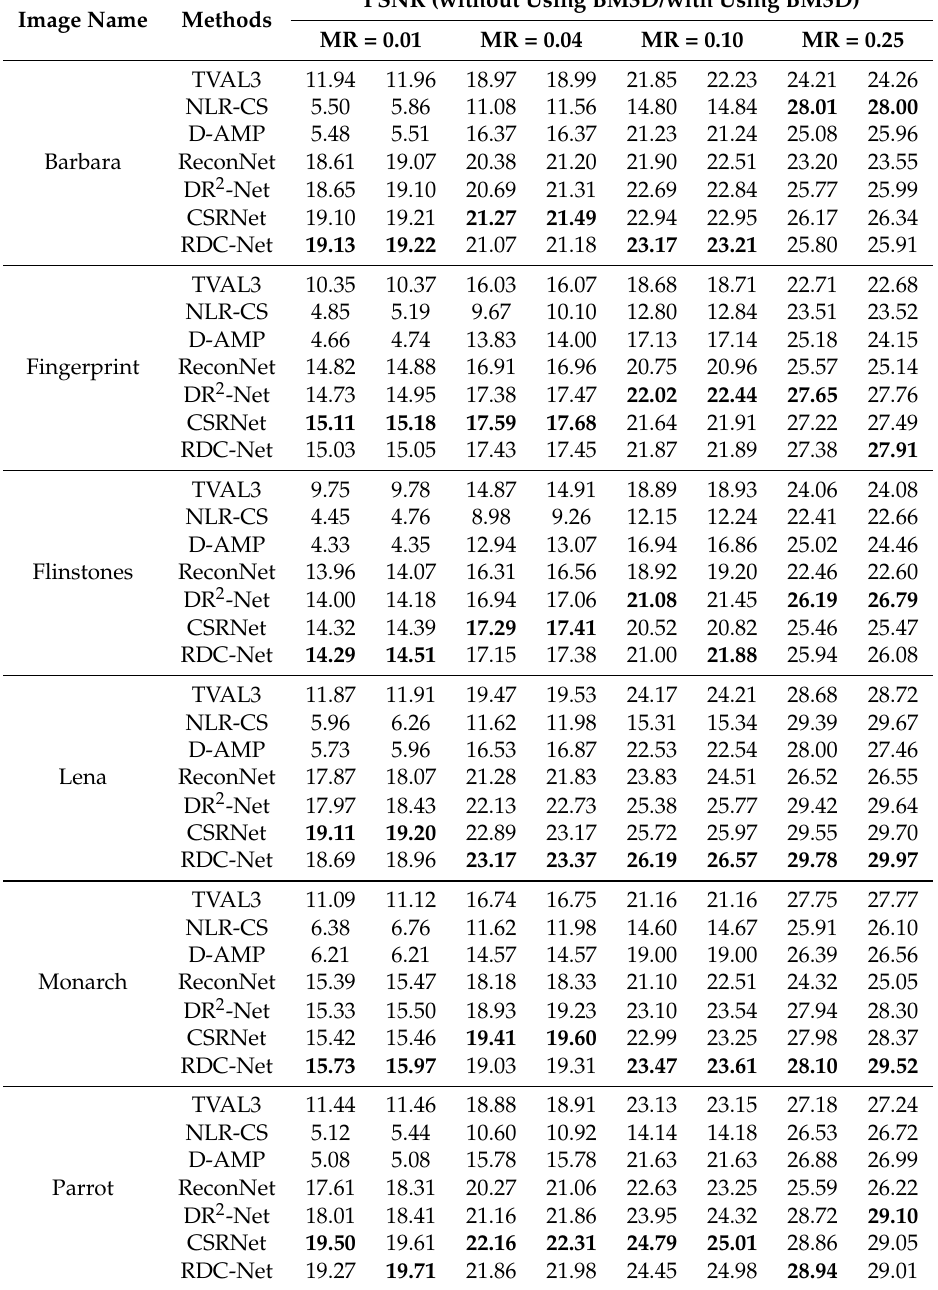
Table 1. Reconstruction results for test images through different algorithms at different measurement rates. “Mean” is the mean value among all test